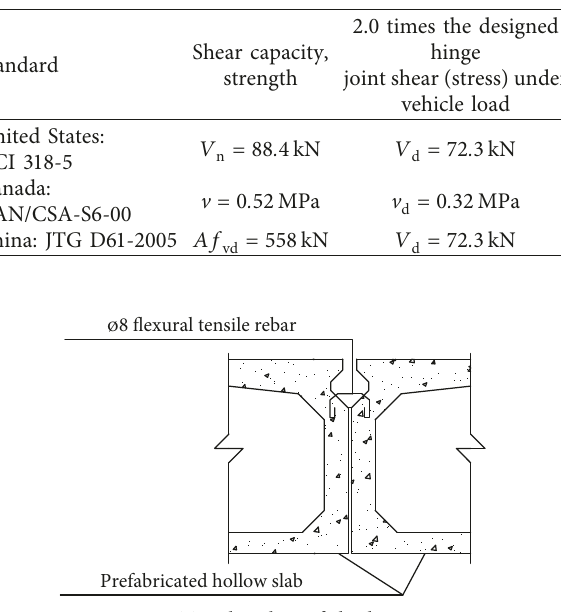
Table 3: Calculation of the shear bearing capacity and the strength of shallow hinge joints.